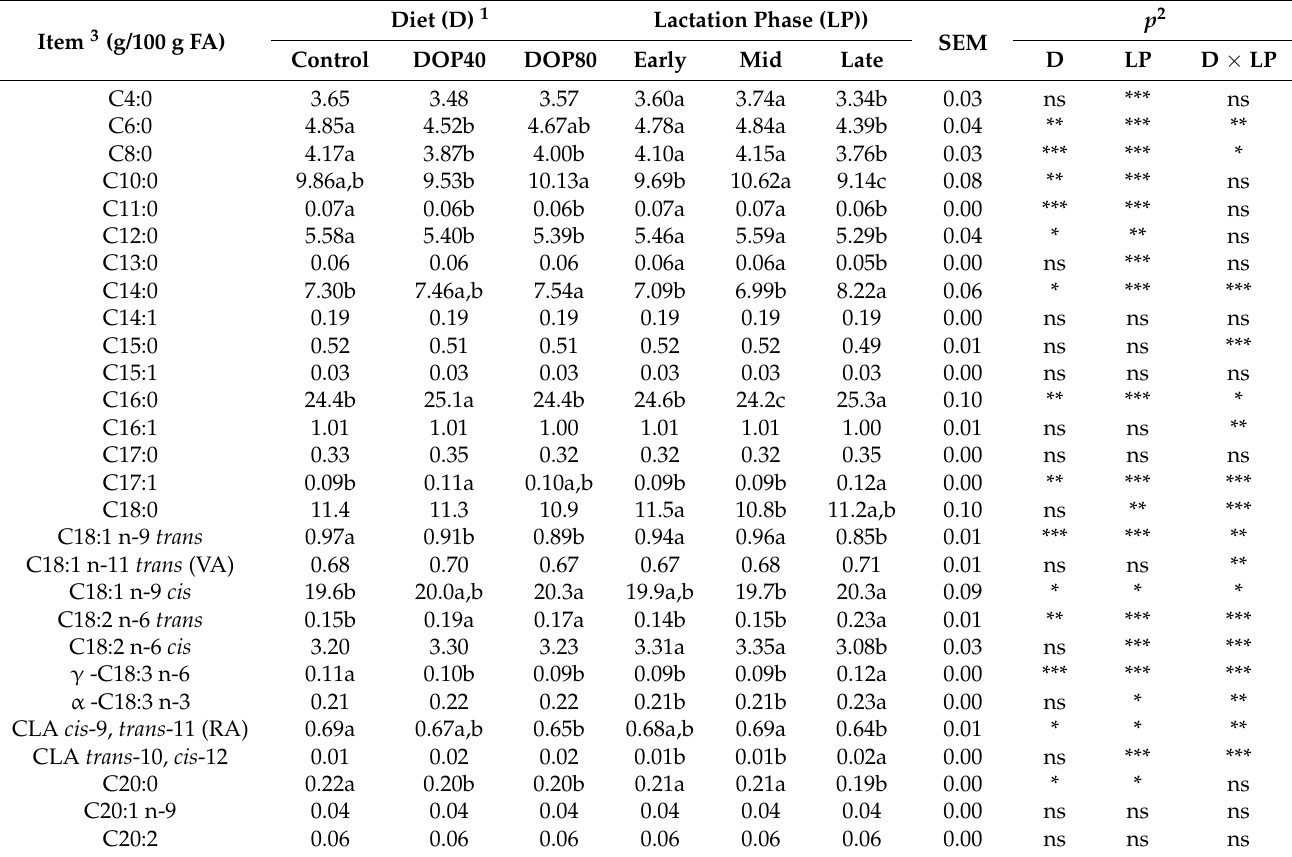
Figure 1. Correlation between total antioxidant capacity (TAC) and total phenolic compounds (TPC) in milk derived from goats fed different diets and at different lactation stages. Table 3. Effects of experimental diets 1 and lactation phase on fatty acid (FA) composition of